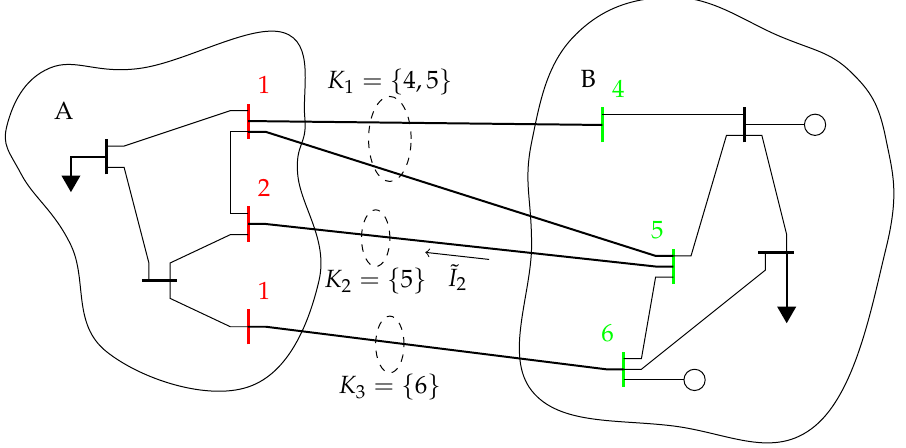
Figure 1. Power transmission corridor with cut-set between receiving area A and sending area B. Receiving boundary buses in red, sending boundary buses in